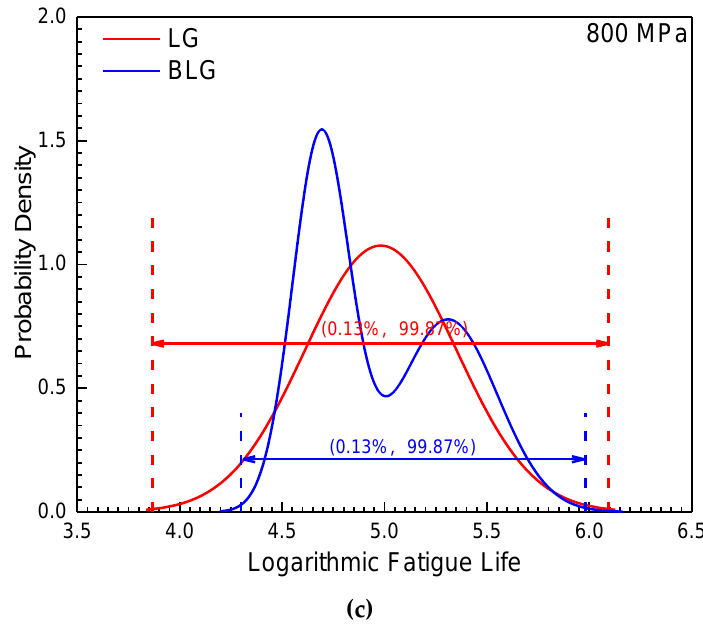
Figure 12. Variations in the BLG and LG. ( a ): 720; ( b ):760; ( c ):800 MPa.